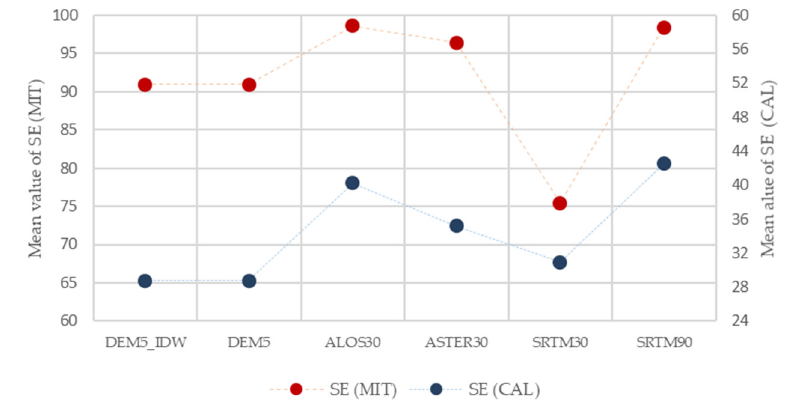
Figure 12. Mean annual soil erosion (SE) calculated for each DEM using the LS factors from the MIT and CAL methods.